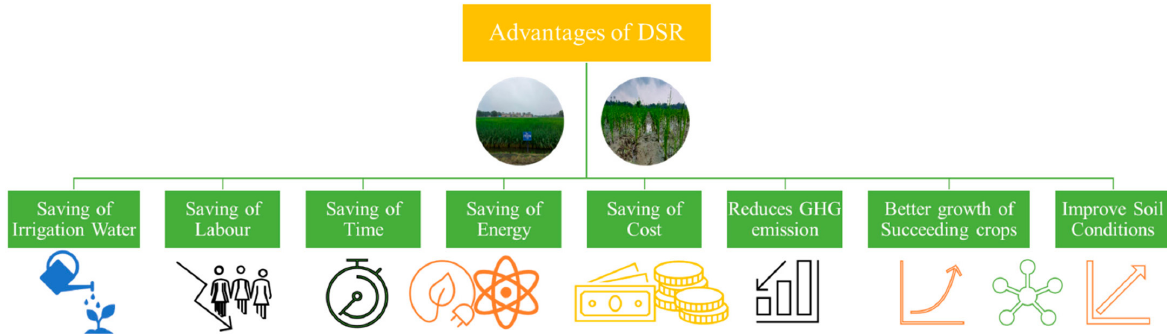
Figure 9. Advantages of adoption of DSR